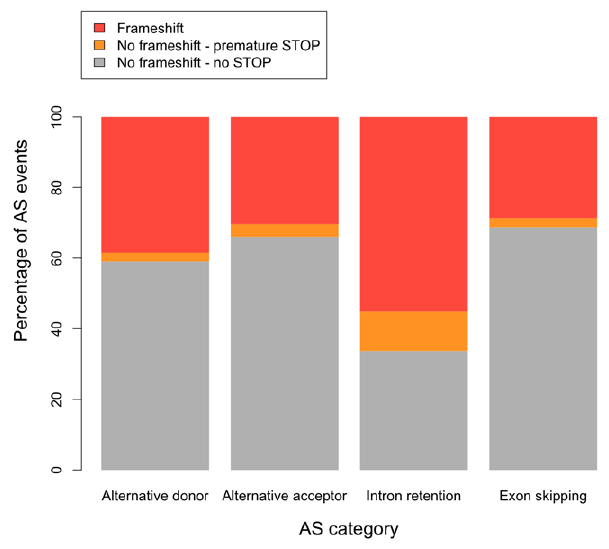
Figure 5. Effects of alternative splicing events on the coding sequence (CDS) in D.pseudoobscura . Stop codons are rare in all alternative splicing (AS) modes. Frameshifts show a more heteroge- neous distribution, with intron retention events harboring most frameshifts.